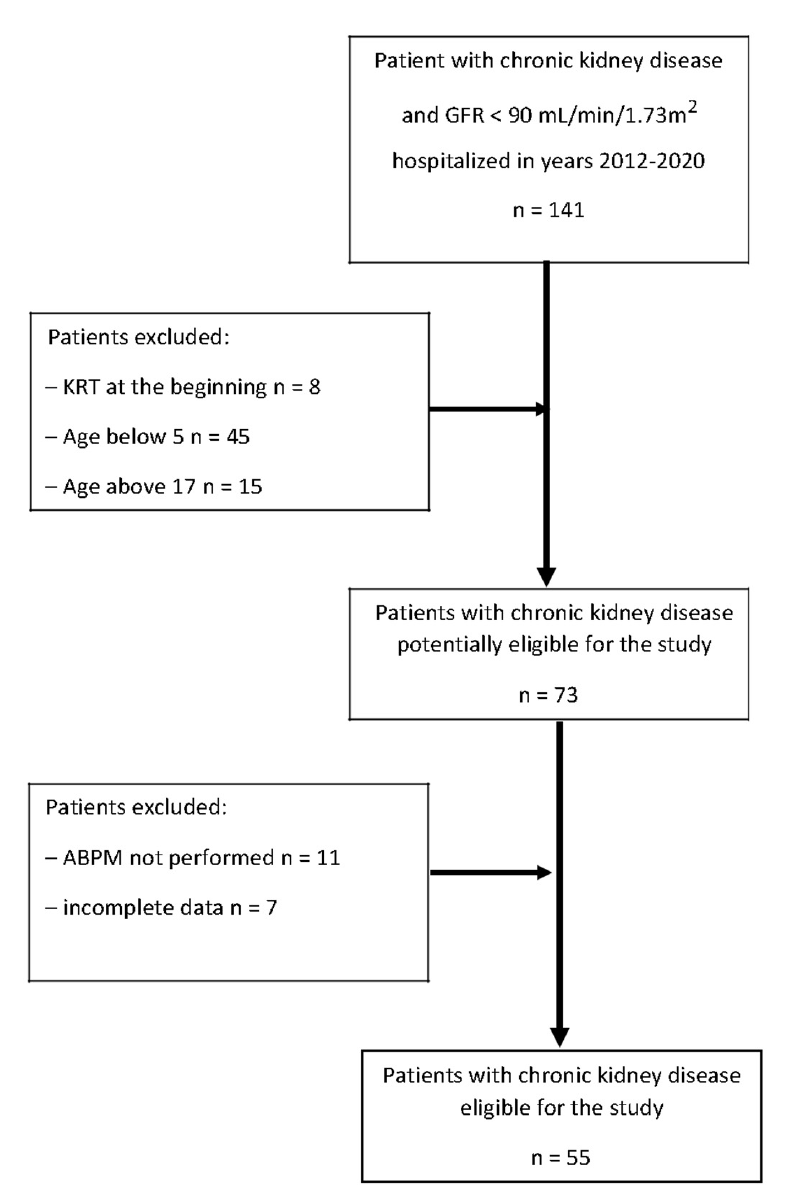
Figure 1. Flowchart of patients with chronic kidney disease hospitalized in the years 2012–2020 (GFR—glomerular filtration rate, KRT—kidney replacement therapy, ABPM—ambulatory blood pressure monitoring).